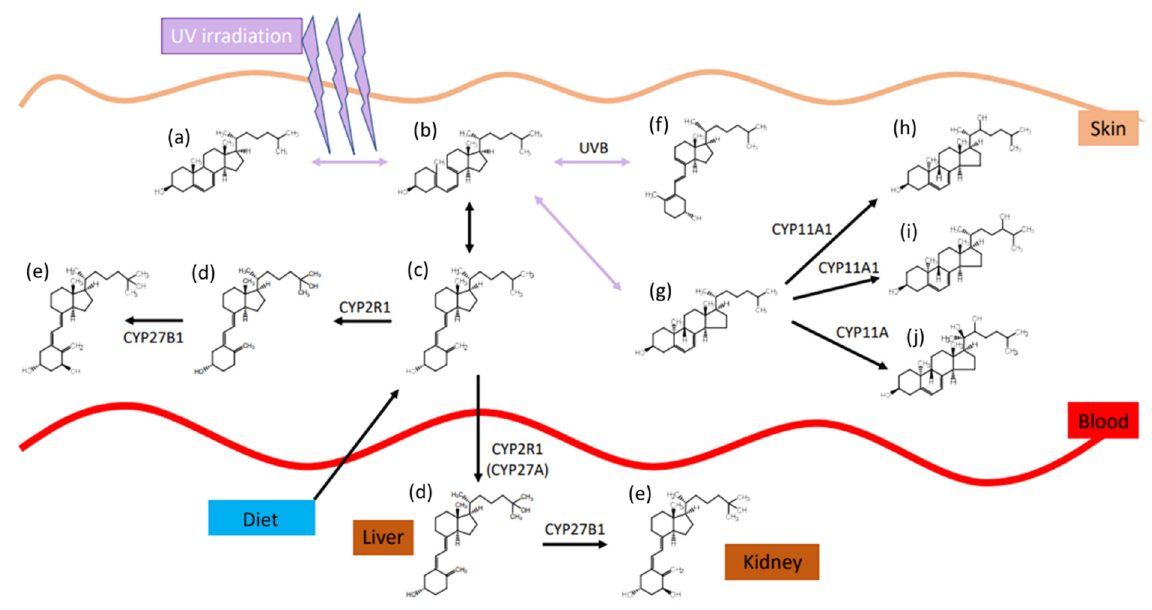
Figure 7. UV B-induced transformations of provitamin D to previtamin D, and consequently to vitamin D, lumisterol, and tachysterol. Provitamin D ( a ) is transformed by UV-light to previtamin D ( b ), followed by a thermally activated trans isomerisation to generate vitamin D ( c ). Enzyme-catalysed reactions in either skin or liver and kidney result in the formation of 25-hydroxyvitamin D ( d ), and finally 1,25-dihydroxyvitamin D ( e ). Alternative phototoinduced pathways are the formation of tachysterol ( f ) from previtamin D or the formation of lumisterol ( g ) by ring-closure. Further enzyme-catalysis of lumisterol results in the formation of 22(OH)lumisterol ( h ), 24(OH)lumisterol ( i ), and 20,22(OH) 2 lumisterol ( j ).